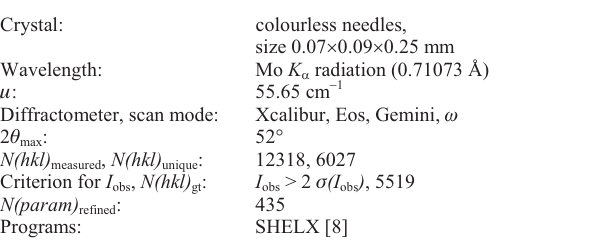
Table 1. Data collection and handling.